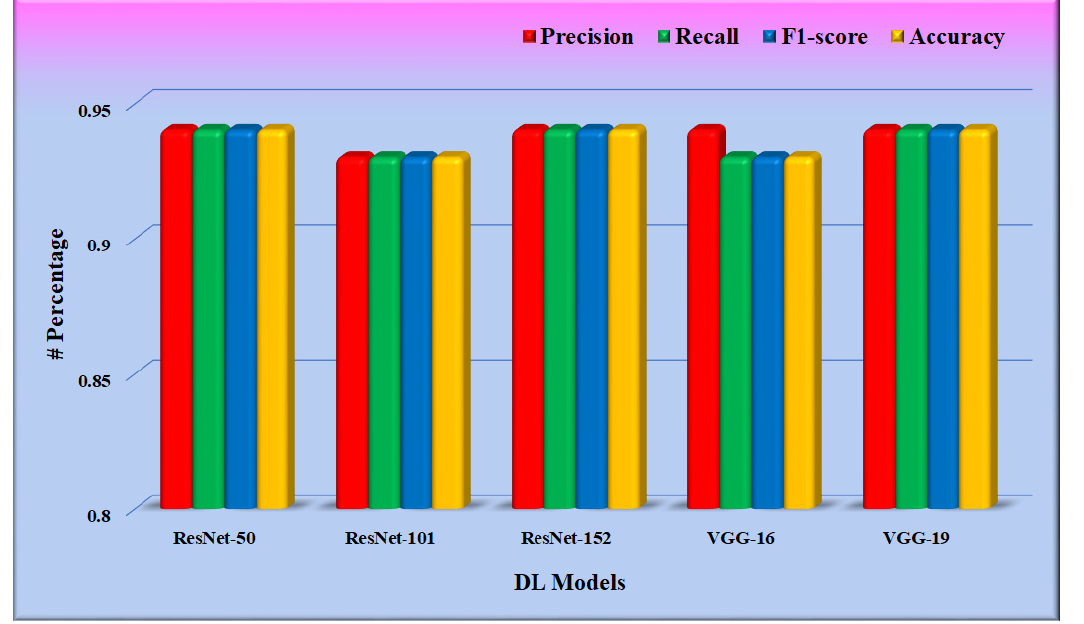
Figure 11. Performance evaluation of the fine-tuned CNN